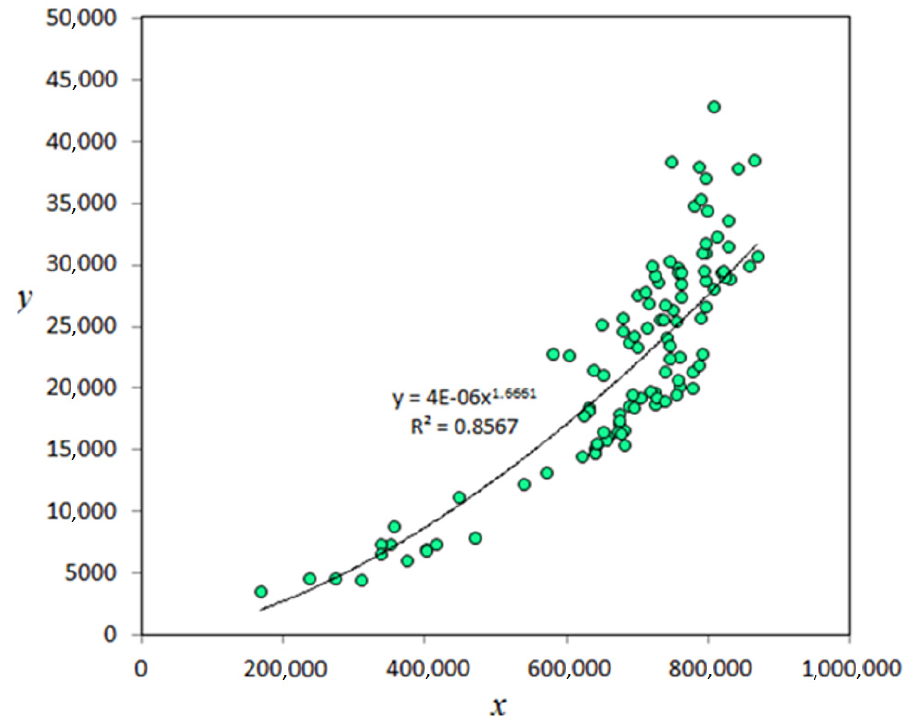
Figure 12. Elastic modulus- x relationship.